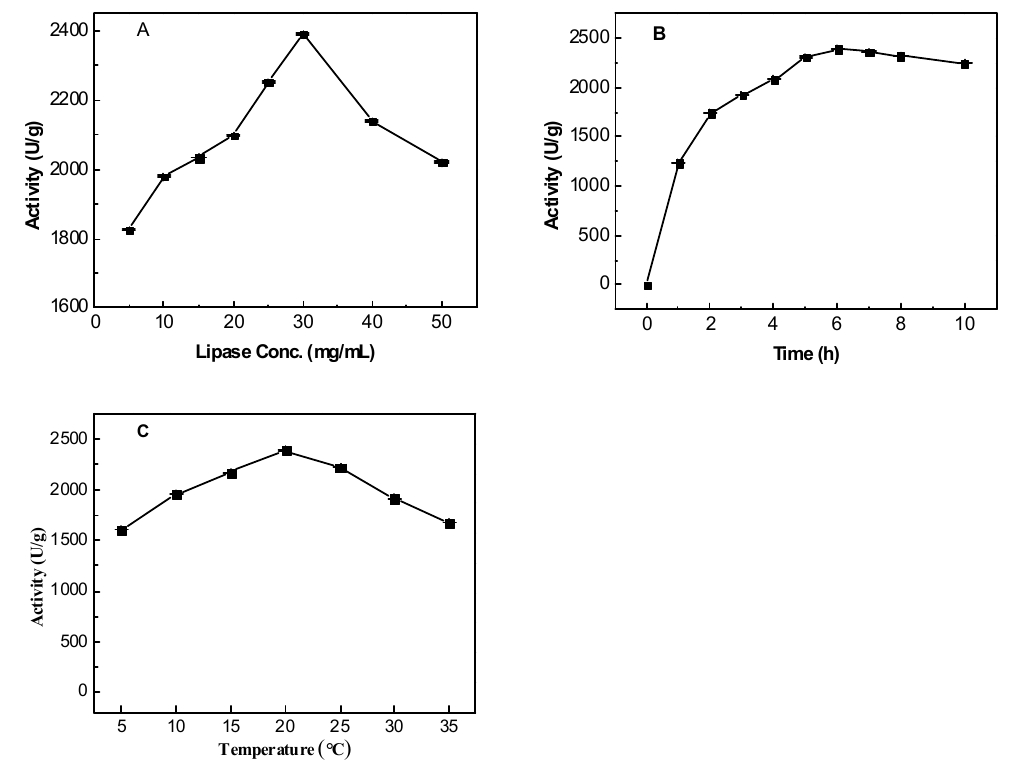
Figure 4. Effect of the parameters on the lipase immobilization. ( A ) lipase concentration, ( B ) time, and ( C ) temperature.